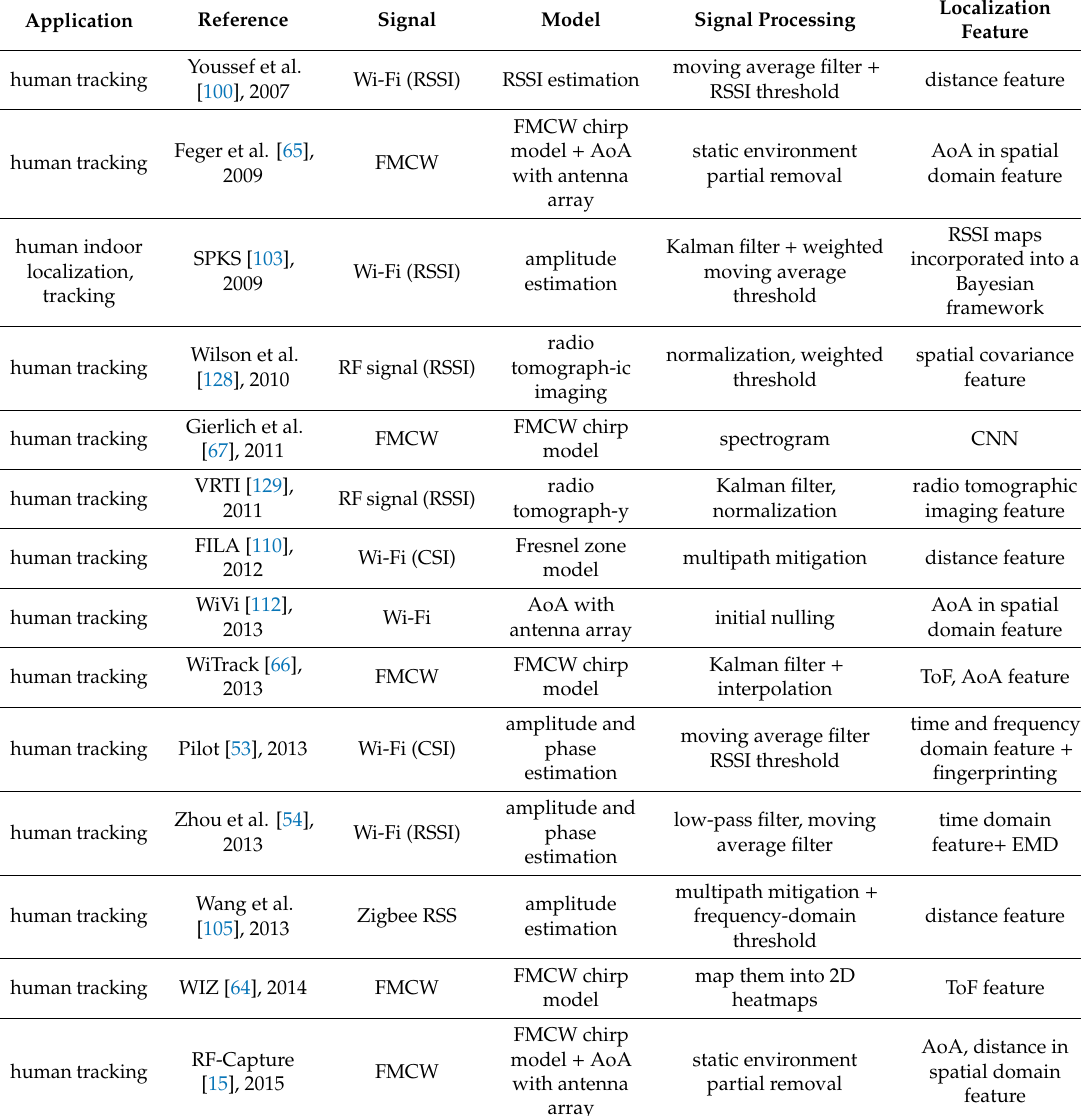
Table 12. Summary of wireless sensing applications: